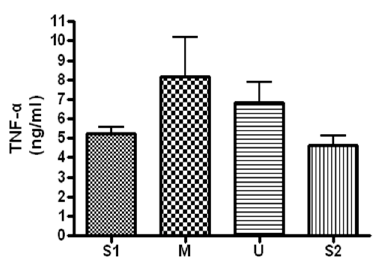
Figure 9. Serum TNF- α concentration in different locations. Values are mean ± S.D. S1: Before start in Seoul, M: Moscow U: Ulaanbaatar S2: Return to Seoul.